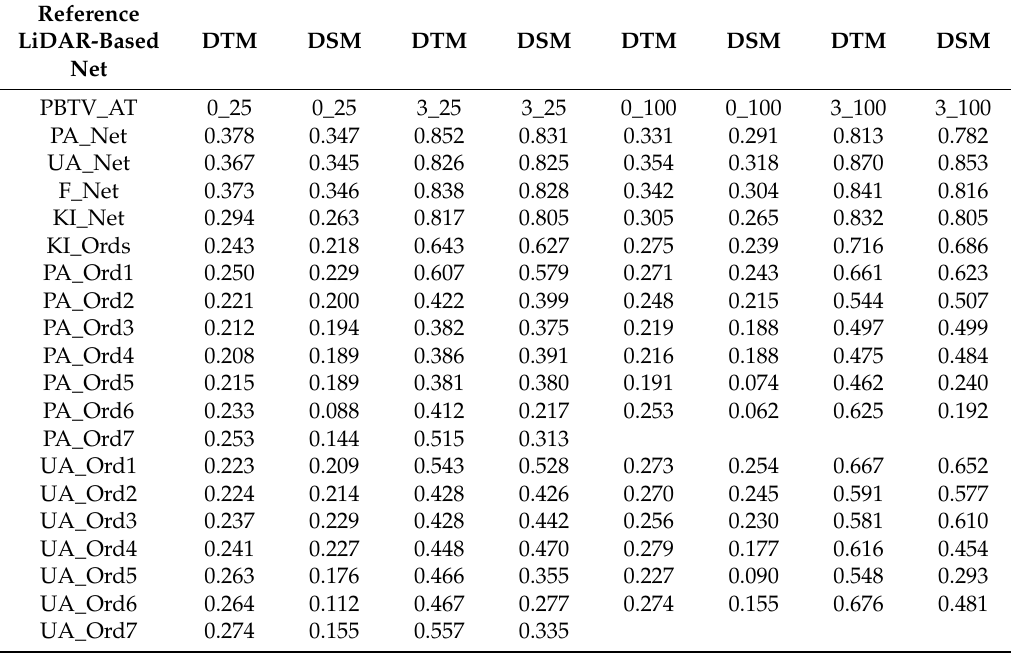
Performance accuracy metrics computed based on the comparison between whole networks/orders extracted from the LiDAR DTM/DSM 12.5 m and the PALSAR DEM 12.5 m at different ATs expressed in the corresponding number of pixels and PBTVs in